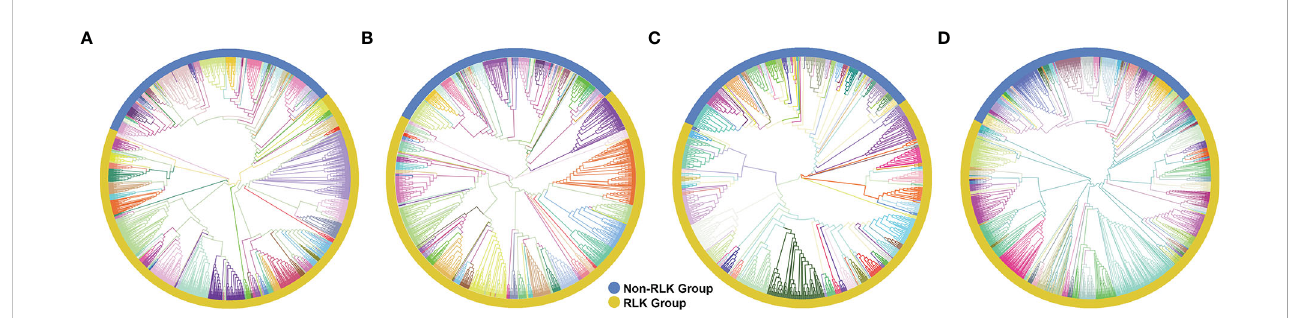
FIGURE 1 Phylogenetic analyses of putative typical protein kinases (PKs) identi fi ed in the Hevea brasiliensis (Hbr), Manihot esculenta (Mes), and Ricinus communis (Rco) genomes. (A) Phylogenetic tree constructed with 2,842 Hbr PKs organized into 123 subfamilies. (B) Phylogenetic tree of the 1,531 Mes PKs organized into 123 subfamilies. (C) Phylogenetic tree of the 863 Rco PKs organized into 125 subfamilies. (D) Phylogenetic tree of all Hbr, Mes, and Rco PKs. Kinase subfamilies are represented by different branch colors. “